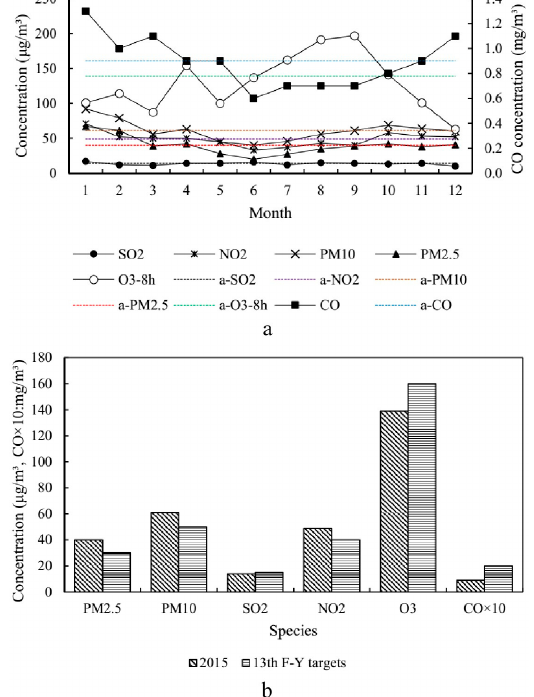
Figure 3. ( a ) Air pollutant monthly concentrations in 2015 averaged in four stations (Baogang, Chisha, Shayuan, and Haizhuhu) in Haizhu district, ( b ) comparison of air quality in 2015 in Haizhu district and the 13th Five-Year targets. (In (a), a-SO 2 , a-NO 2 , a-PM 10 , a-PM 2.5 means 2015 annual value for SO 2 , NO 2 , PM 10 , PM 2.5 , respectively; a-O 3 -8h means the 90th percentile of O 3 -8h in 2015; a-CO means the 95th percentile of the CO daily concentration in 2015; other pollutants: monthly-averaged concentrations. In (b), O 3 : the 90th percentile of O 3 -8h in a year; CO: the 95th percentile of the CO daily concentration in a year; other pollutants: annually-averaged concentrations. These parameters were adopted according to the national standards in China [66].)